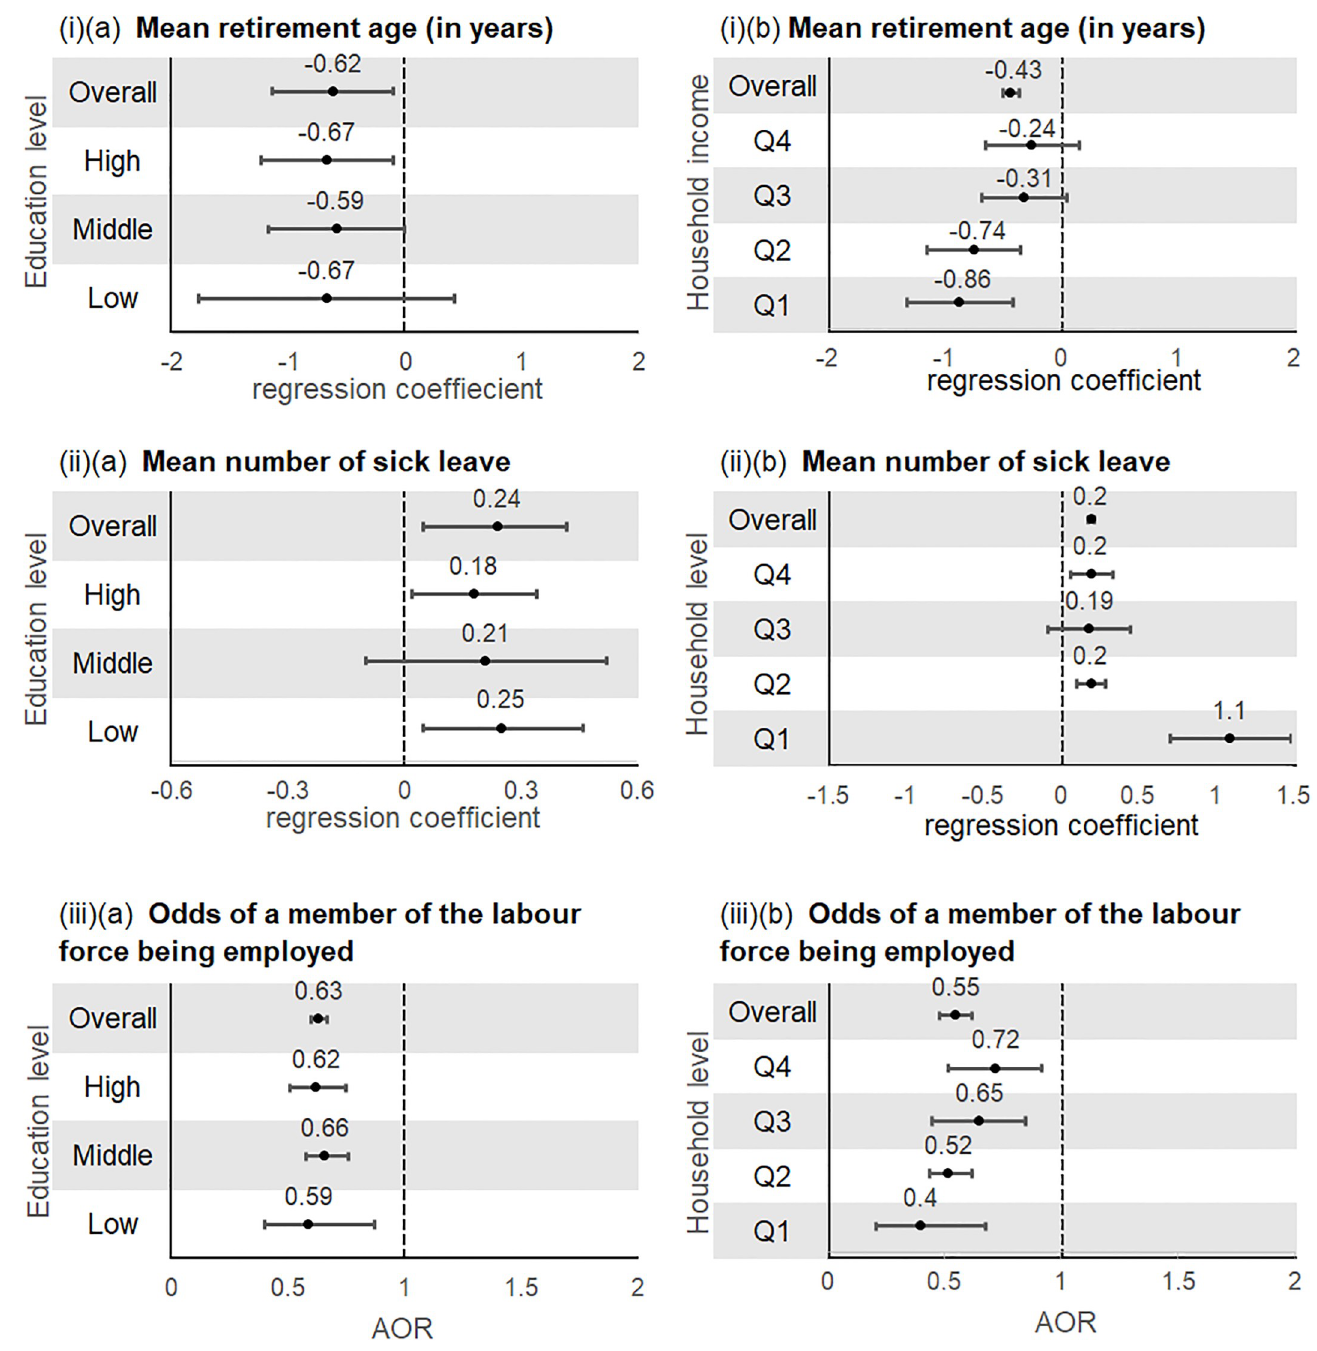
Fig 7. Associations between multimorbidity with (i) mean retirement age (ii) mean number of sick leave days and (iii) odds of being unemployed by (a) education level and (b) household income (Australia) + . + Multivariable negative binomial regression models and multivariable logistic regression models were adjusted for age, sex, marital status, household income (if stratified by education)/education (if stratified by household income), geographical status, country of birth, aboriginal status, body mass index, physical activity, alcohol intake, and smoking.